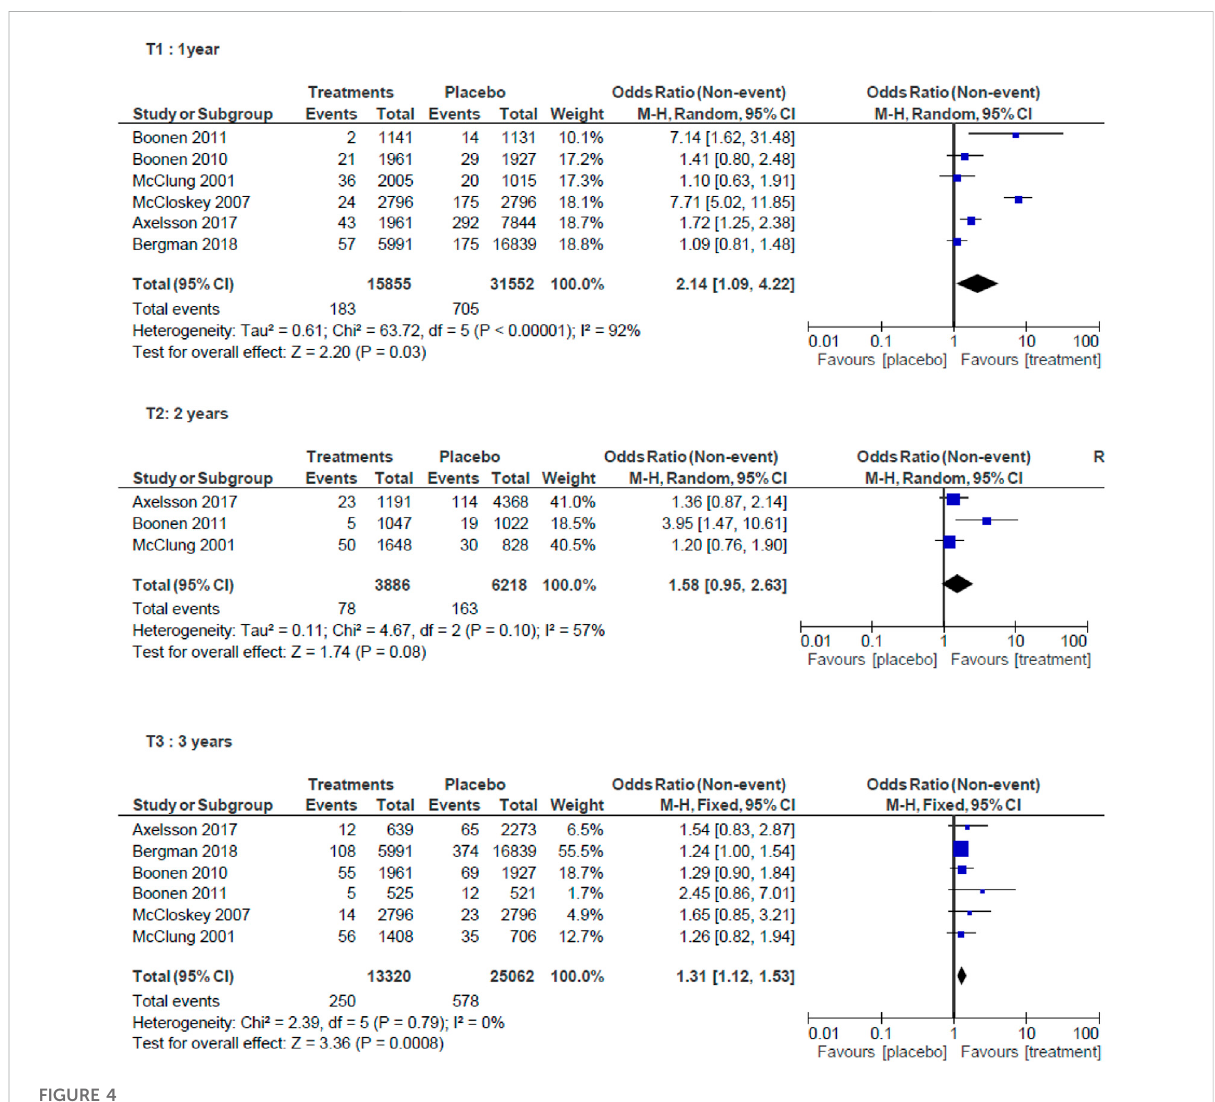
FIGURE 4 Meta-analysis of hip